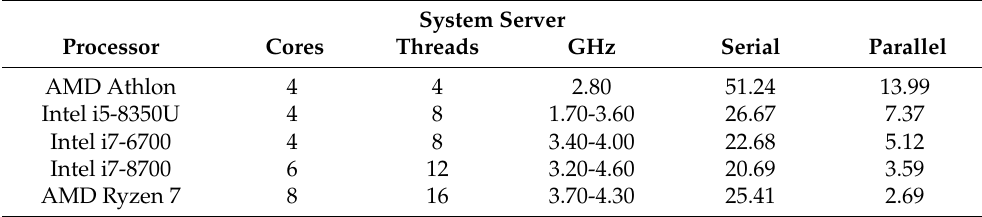
Table 2. “Spending an e-coin” running times (in